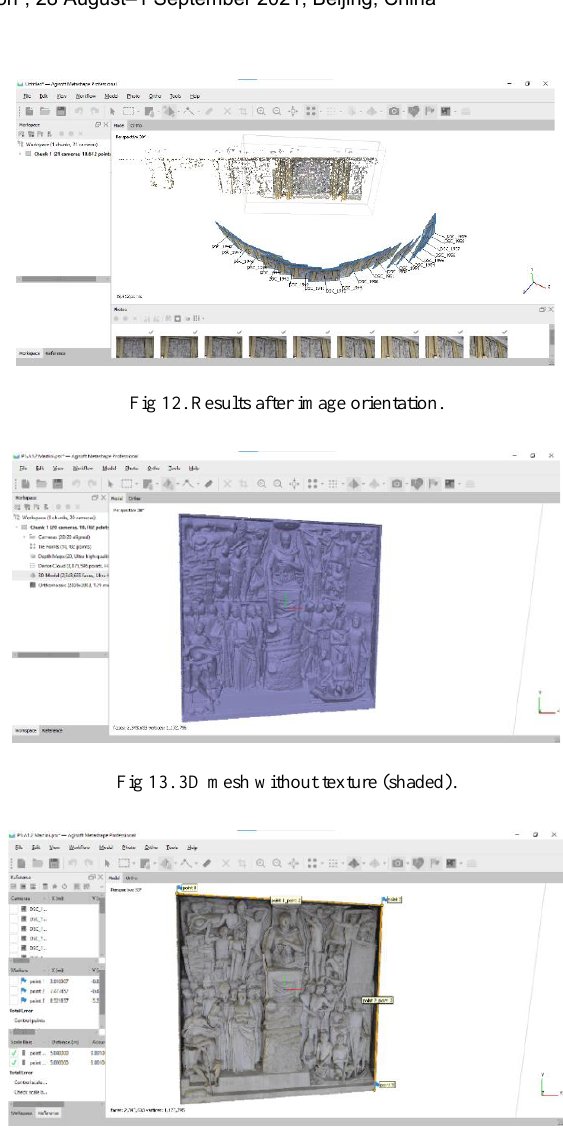
Fig 14. Textured mesh scaled using control